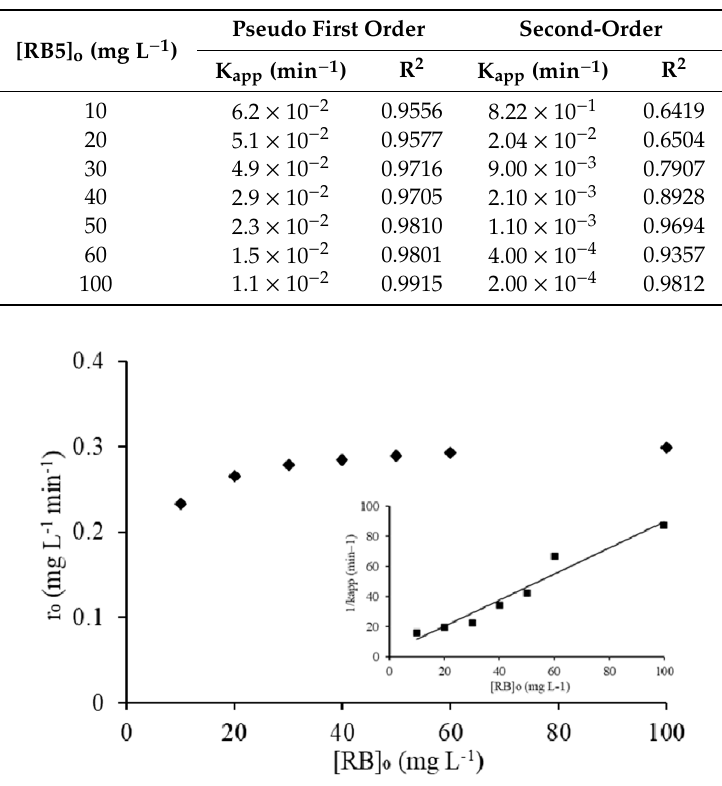
Figure 14. E ff ect of RB5 concentration on the initial rate of decolorization, inset: plot of reciprocal of apparent rate (K app ) of decolorization against RB5 initial concentration.